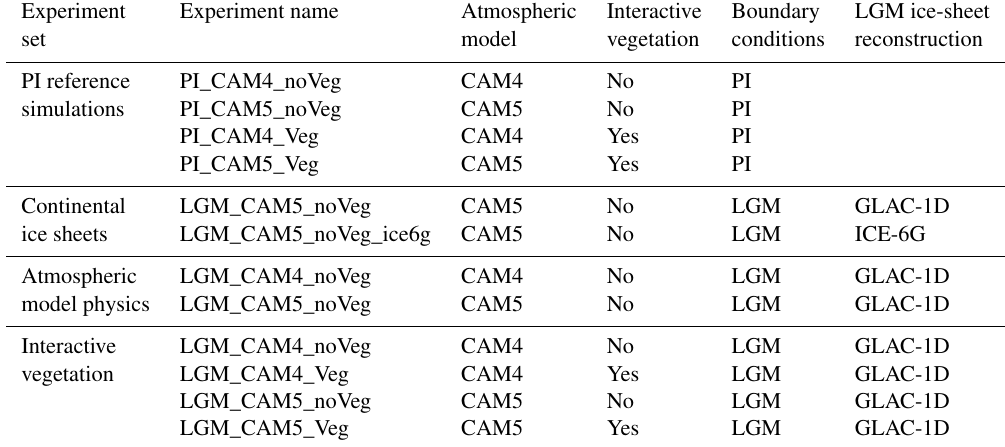
Table 2. List of simulations included in the three sets of CESM LGM experiments and the PI reference simulations. The following ab- breviations are used: noVeg indicates no interactive vegetation; Veg indicates including interactive vegetation; PI indicates pre-industrial; LGM indicates the Last Glacial Maximum; CAM4/5 indicate Community Atmosphere Model version 4 or version 5; GLAC-1D indicates GLAC-1D ice-sheet reconstruction (Ivanovic et al., 2016); ice6g indicates ICE-6G ice-sheet reconstruction (Peltier et al., 2015).